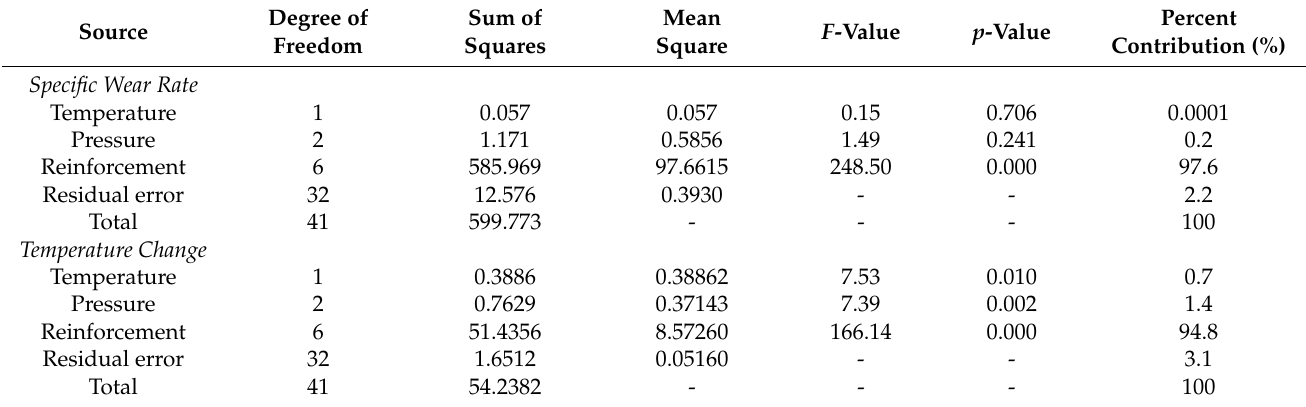
Table 4. Analysis of variance for S/N ratios of experimental